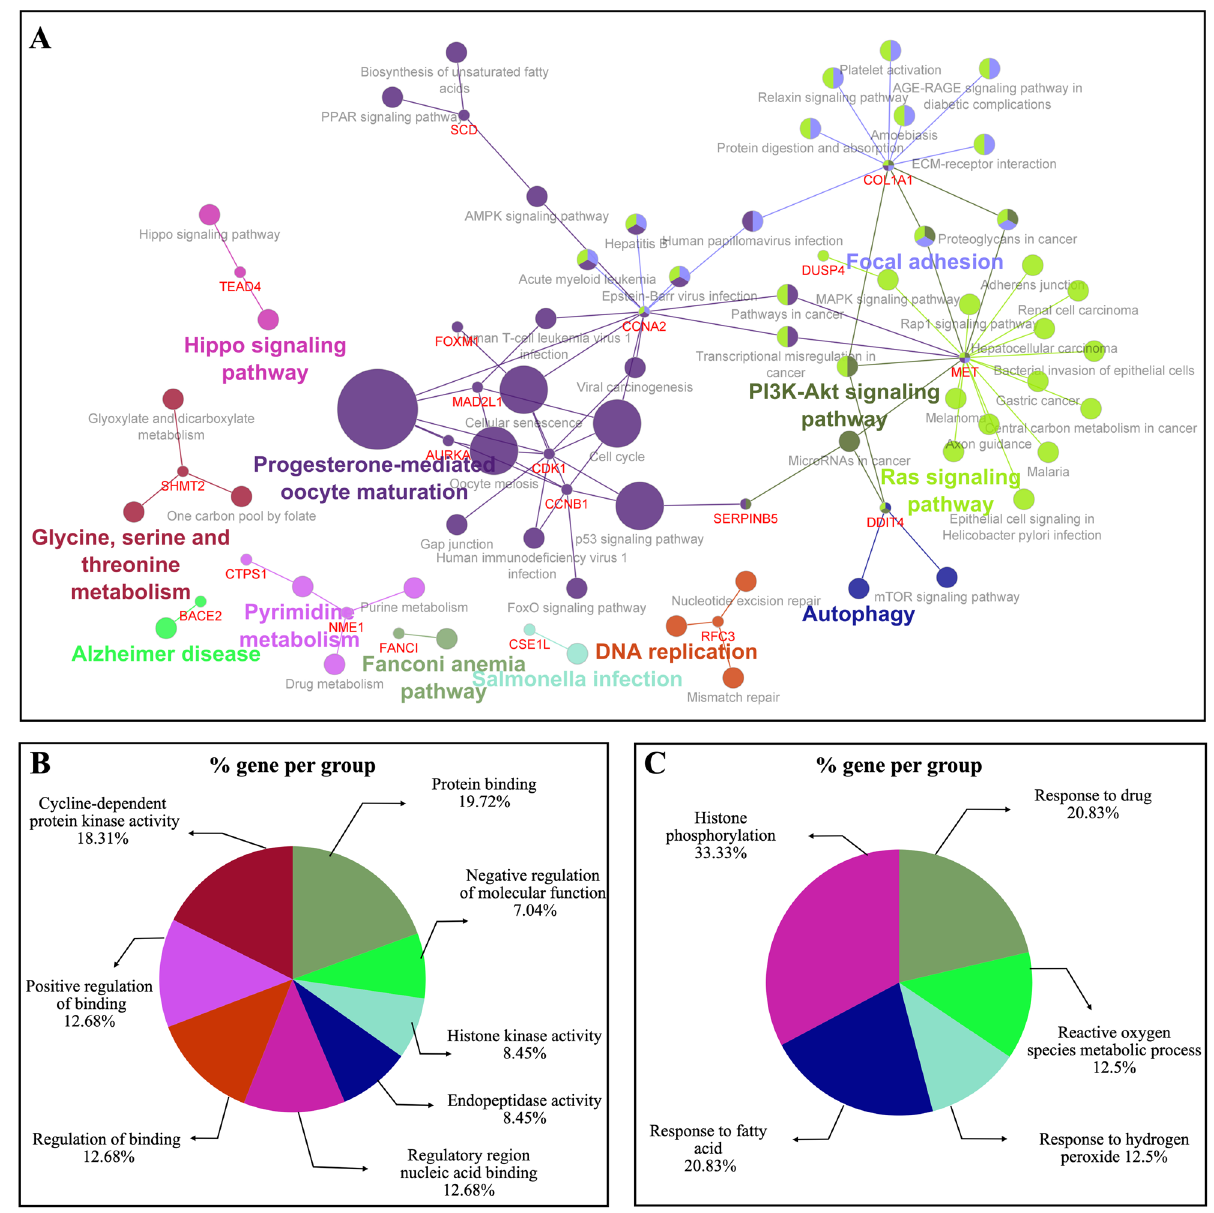
Figure 4. KEGG pathways and gene ontology (GO) analysis for hub genes in Cytoscape software by ClueGO plug-in. ( A ) KEGG pathway analysis for 29 obtained hub genes of protein–protein interaction network. ( B ) Gene ontology analysis for domains of molecular function (MF) and ( C ) biological process (BP) for 14 hub genes involved in KEGG pathways with P value <